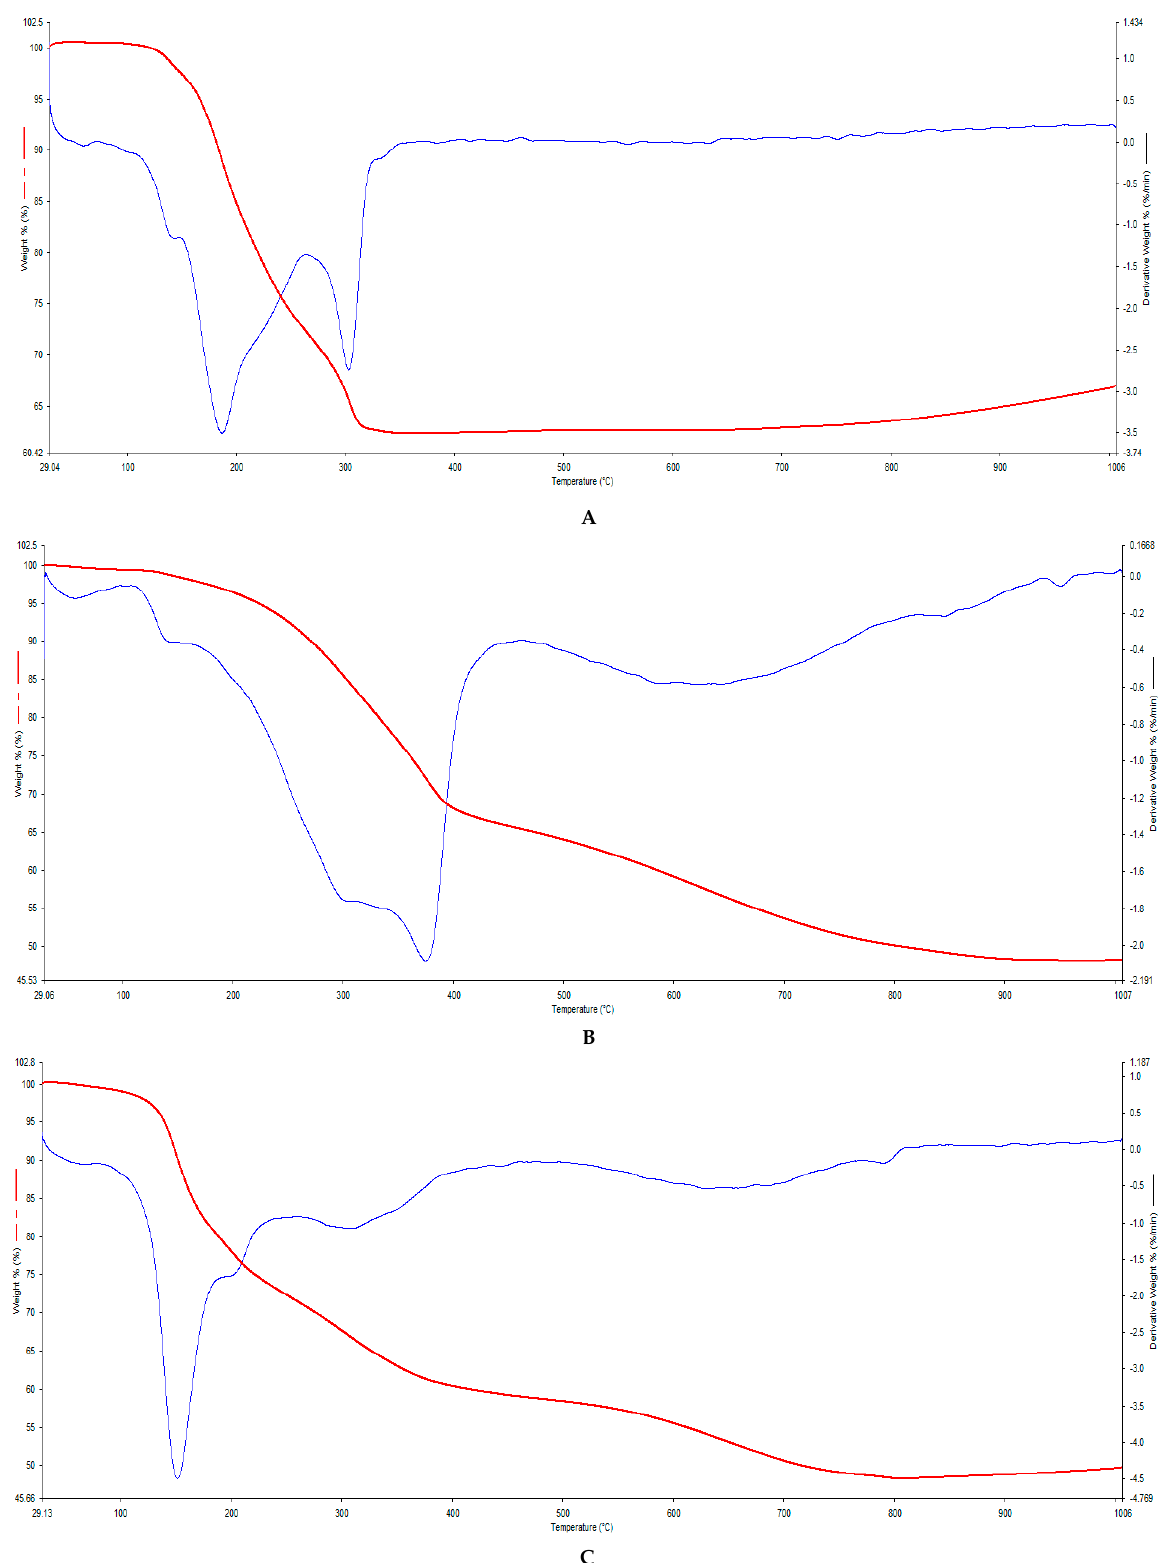
Figure 3. TGA curve (red) and DTG curve (blue) of A-OMAgNs ( A ), M-OMAgNs ( B ), and MH-OMAgNs ( C ).